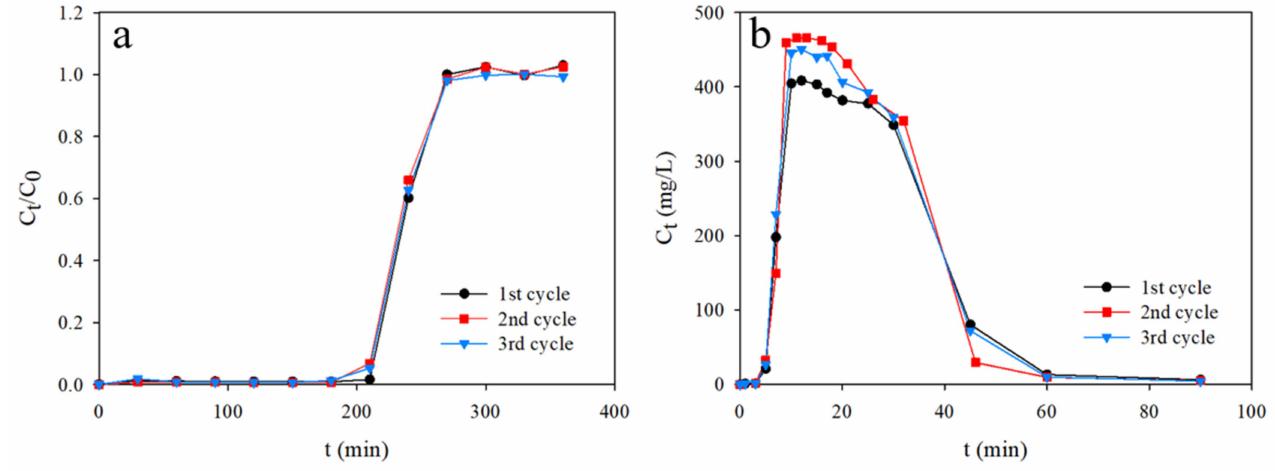
Figure 6. ( a ) Adsorption and ( b ) desorption curves of PEI-chitin for